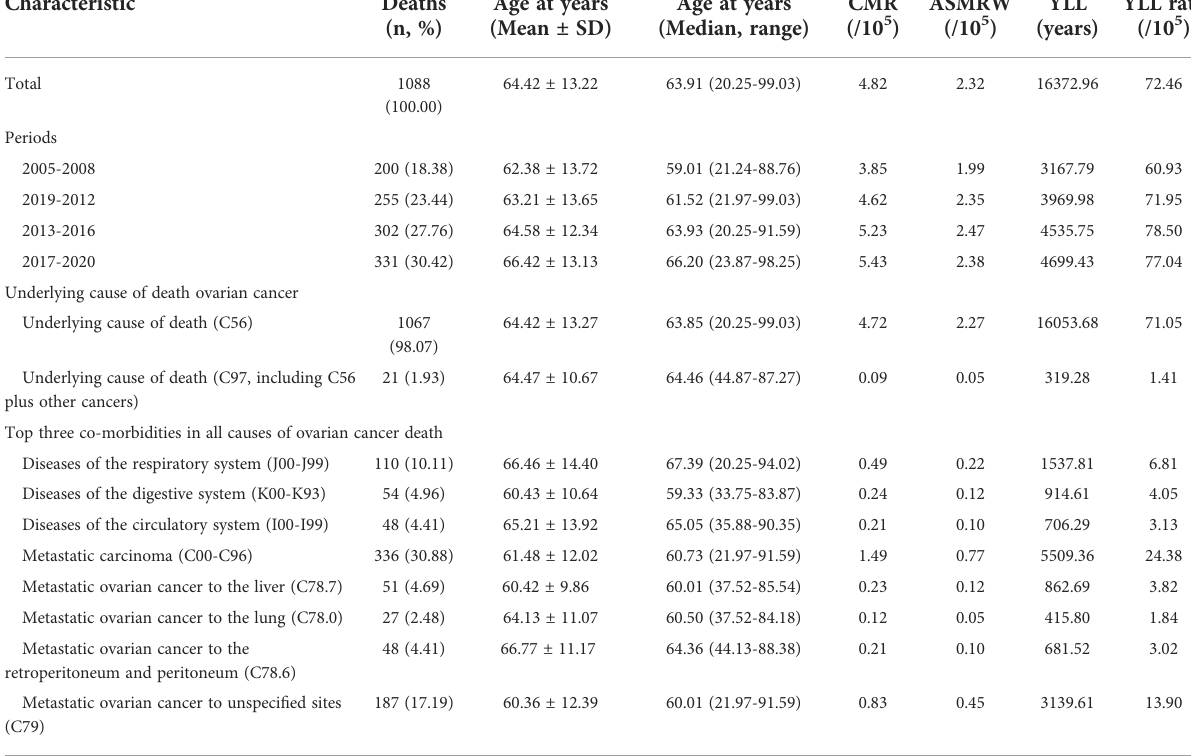
TABLE 1 Baseline characteristics of ovarian cancer death in Pudong, Shanghai, China from 2005 to 2020.